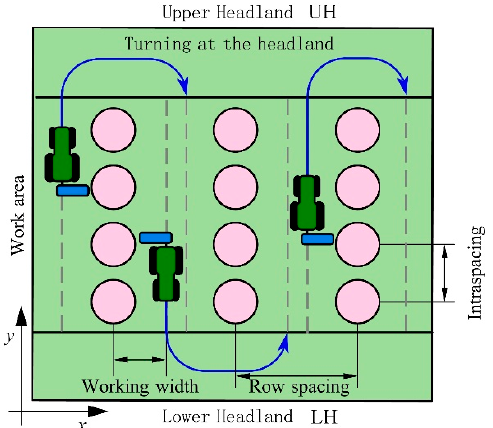
Figure 1. Schematic diagram of multiple tractors working in standard peach orchard.